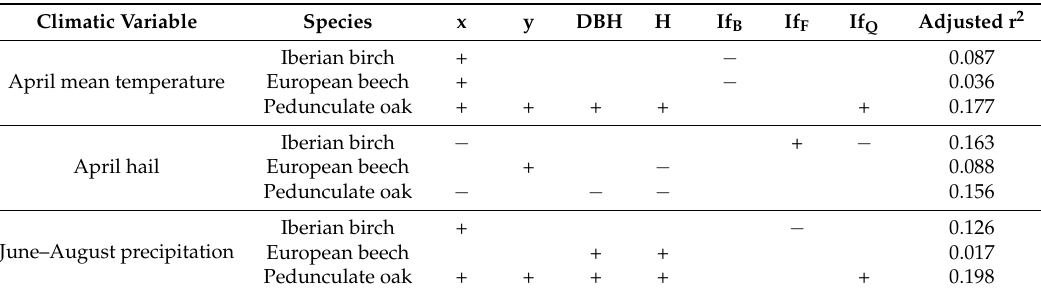
Table 5. Selected multiple regression models explaining the variability in climate–growth relationships at the individual tree